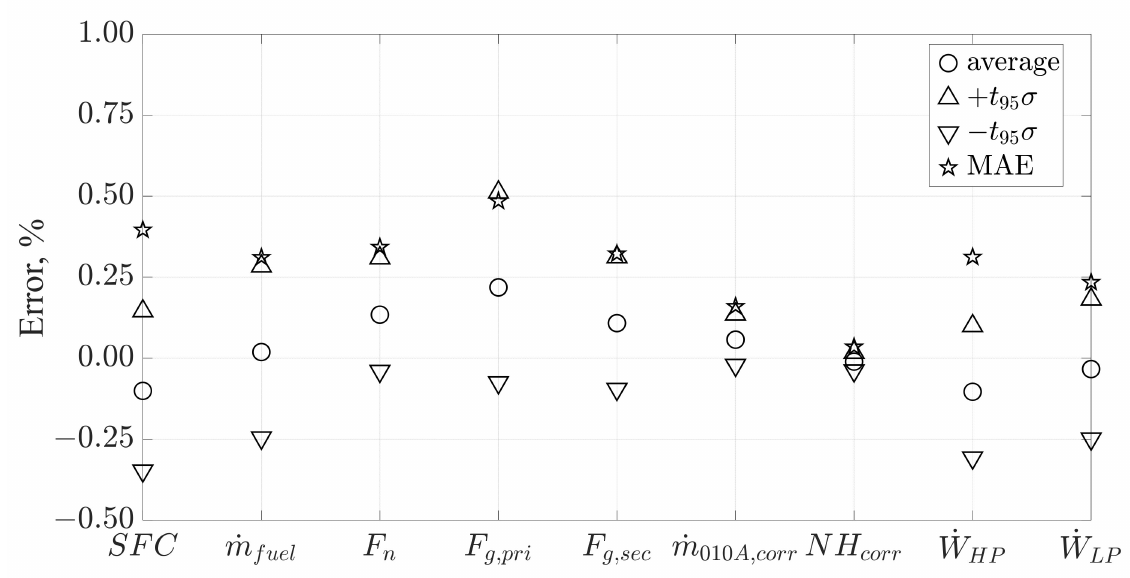
Figure 5. ‘Ground’ condition error statistics ( n = 42).